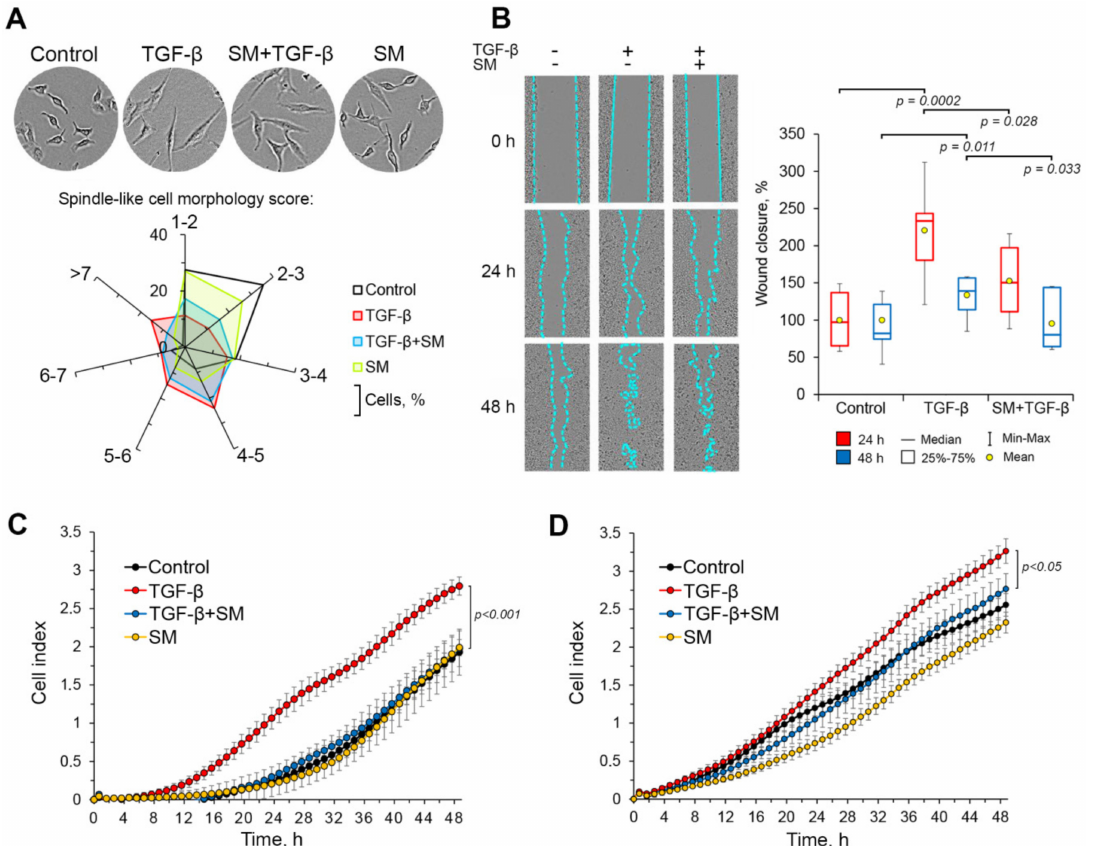
Figure 5. SM e ff ectively inhibits TGF- β -stimulated EMT-associated processes in A549 cells. ( A ) SM increases the percentage of roundish-shaped cells undergoing TGF- β -induced EMT. A549 cells were incubated with the presence of TGF- β and / or SM for 48 h followed by the evaluation of cellular morphology by phase contrast microscopy and the calculation of spindle-like cell morphology score, according to the formula (1), using ImageJ tool. ( B ) SM e ff ectively decreases wound healing rate of TGF- β -stimulated A549 cells. The scratched cell monolayers were incubated with the presence or absence of TGF- β (50 ng / mL) and SM (0.5 µ M) for 24 h and 48 h after that the analysis of wound closure capacity was carried out using phase contrast microscopy data. ( C ) SM inhibits TGF- β -stimulated motility of A549 cells. The cells were seeded in the upper chamber of cell invasion / migration (CIM)-Plate and treated with TGF- β (50 ng / mL) and / or SM (0.5 µ M) for 48 h. Fetal bovine serum (FBS)-mediated migration of the cells to the lower chamber was analyzed using the xCELLigence Real-Time Cell Analyzer Dual Plates (RTCA DP) system. ( D ) SM inhibits TGF- β -stimulated invasion of A549 cells. The cells were seeded in the upper chamber of CIM-Plate, the bottom of which was covered by Matrigel, and treated with TGF- β (50 ng / mL) and / or SM (0.5 µ M) for 48 h. Invasion of the cells to lower chamber, containing 10% FBS, was analyzed by xCELLigence RTCA DP